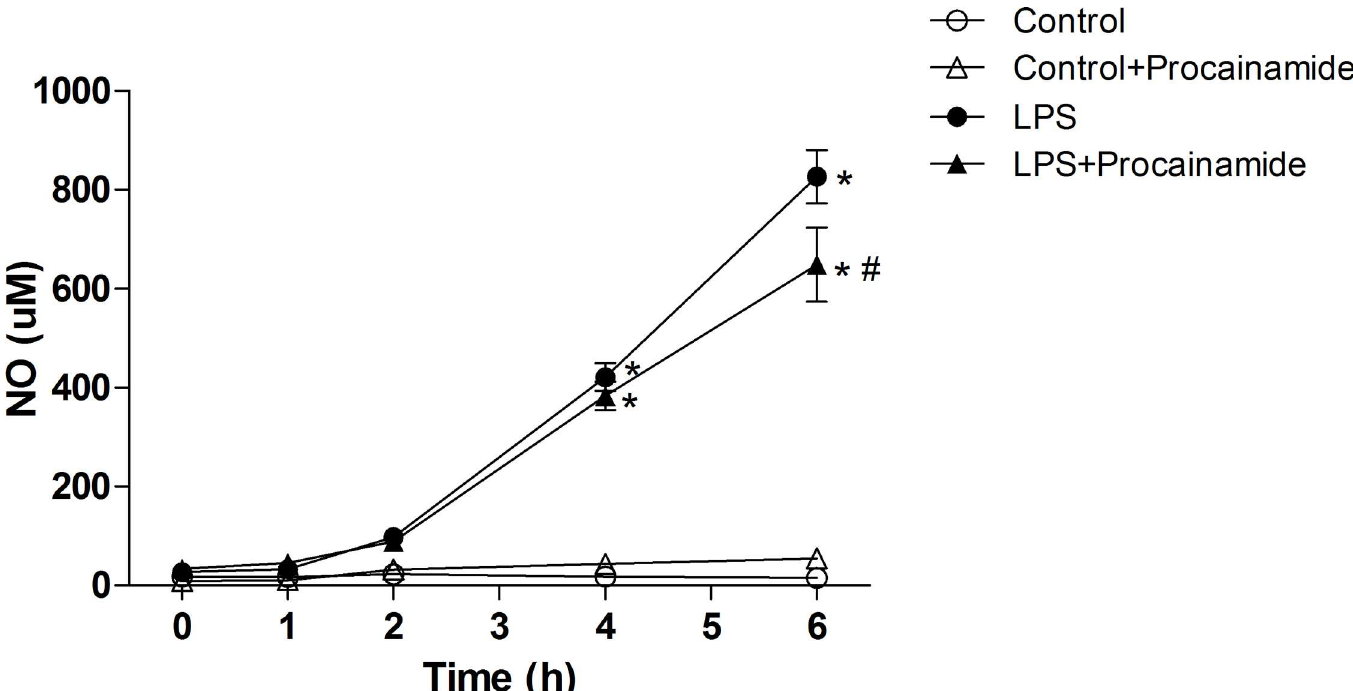
Fig 3. Effects of procainamide on plasma nitric oxide (NO) in endotoxemic rats. Depictedare the changes during the experimental period in different groups of animals that received saline at time 0 (Control, n = 5), received saline as in Control group and then received procainamide at 1 h (Control + Procainamide, n = 5), received LPS at time 0 (LPS, n = 5), and received LPS at time 0 and then received procainamide at 1 h (LPS + Procainamide, n = 5). Data are expressed as mean ± SEM. * P < 0.05, all versus Control rats; # P < 0.05, with versus without procainamide in LPS rats.